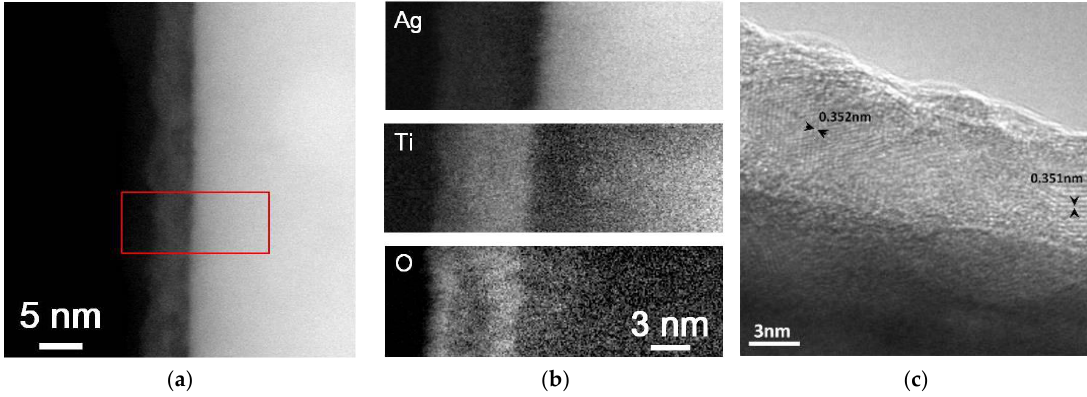
Figure 4. Microstructure analytic results of the outmost oxide shell of a Ag/TiO 2− x /TiO 2 nanowire: ( a ) STEM-HAADF image, ( b ) EELS elemental mapping taken from the marked region in ( a ), ( c ) HRTEM images.